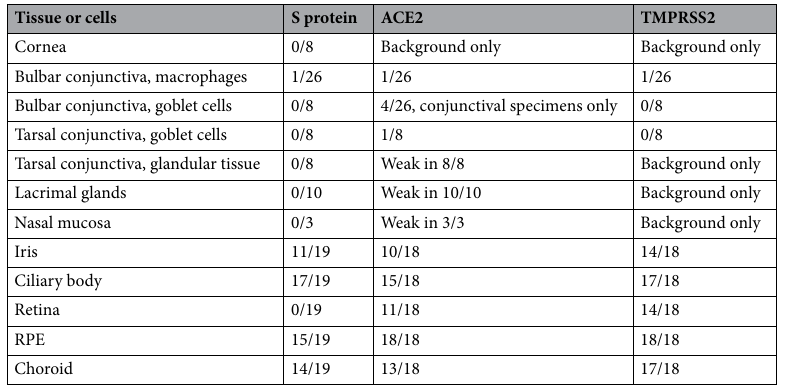
Table 2. Staining results. Indicated are numbers of specimens showing staining/total number of